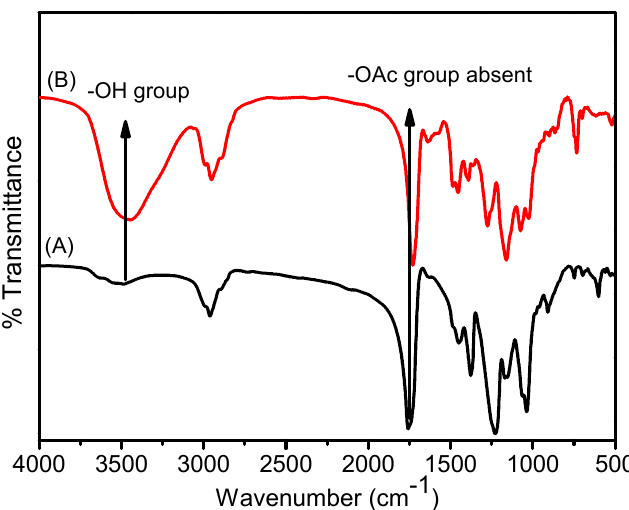
Figure A1. FTIR spectra. (A) Dried C200 organogel. (B) Dried DC200 hydrogel.